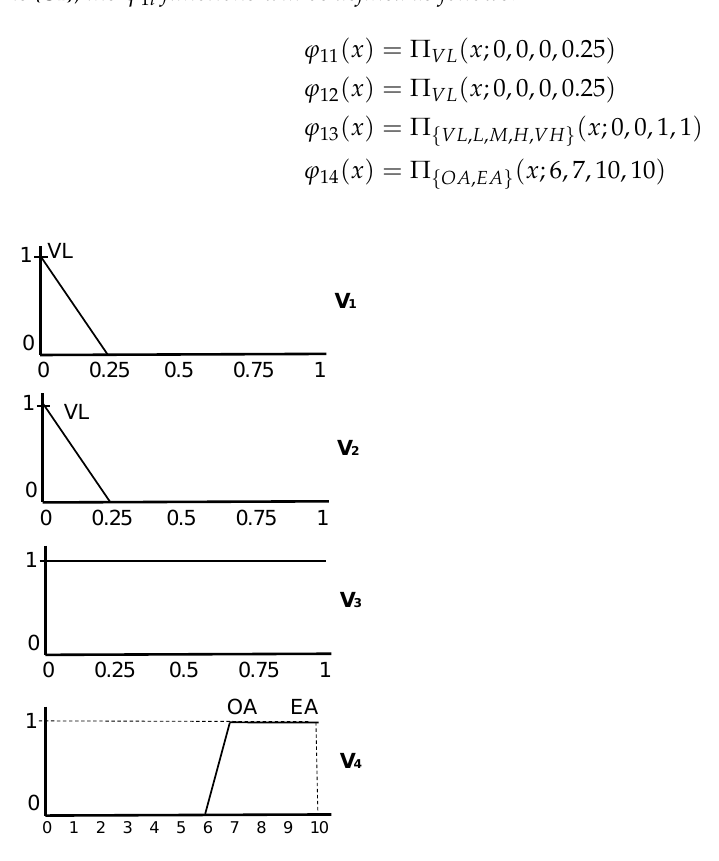
Figure 5. ϕ 1 i functions for each variable V i in the rule r 1